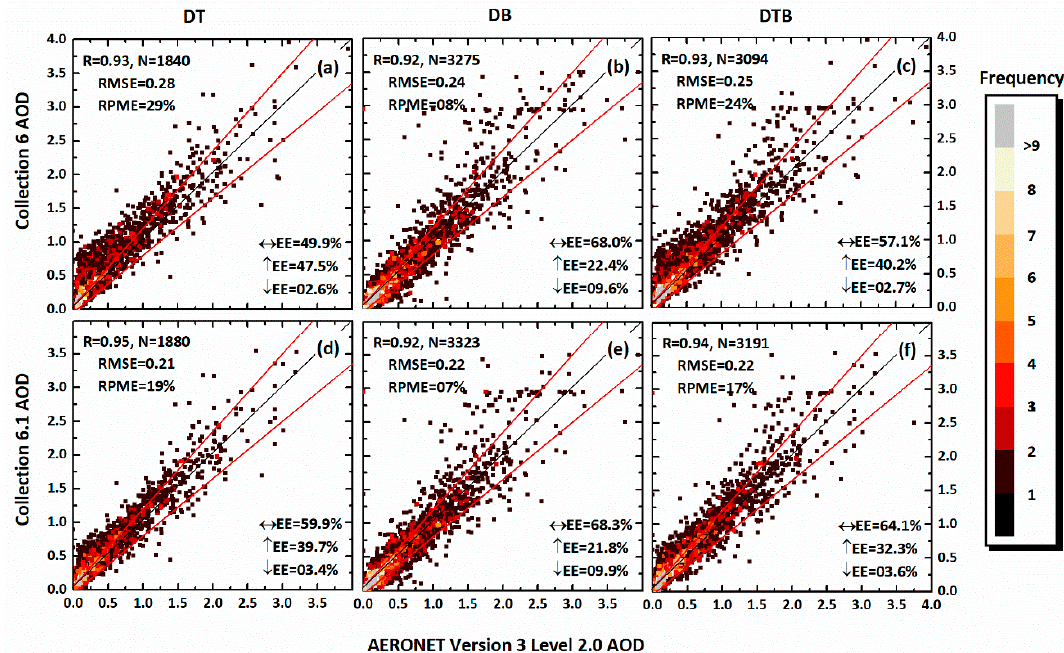
Figure 3. Validation of MODIS AOD retrievals from 2004–2014 at the regional scale: DT C6 ( a ), DB C6 ( b ), DTB C6 ( c ), DT C6.1 ( d ), DB C6.1 ( e ), and DTB C6.1 ( f ). The black line is the 1:1 line and red lines are the expected error envelope.